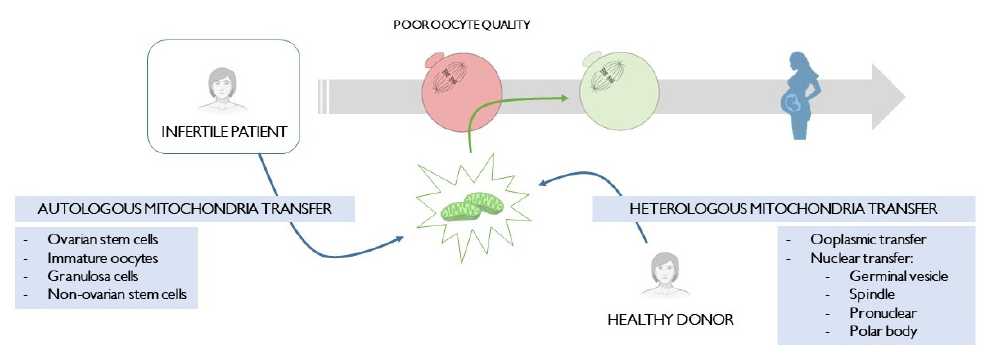
Figure 1. Schematic representation of mitochondria transfer techniques in order to improve poor oocyte quality in infertile patients. Autologous and heterologous techniques are specified.